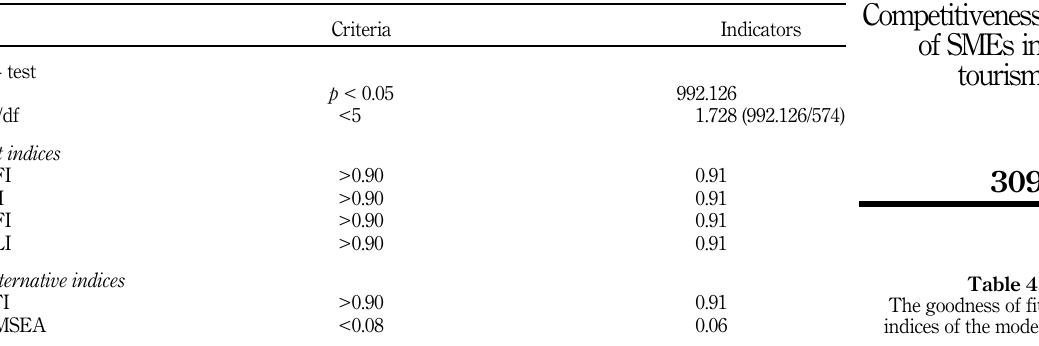
Table 4. The goodness of fit